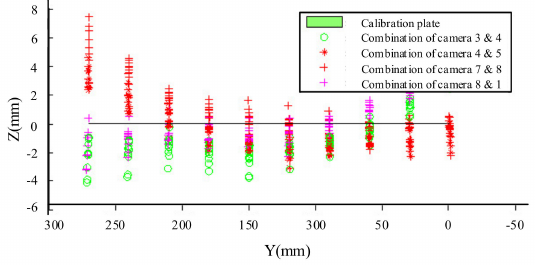
Figure 12. Y-Z plane of underwater 3D reconstruction with partial combined